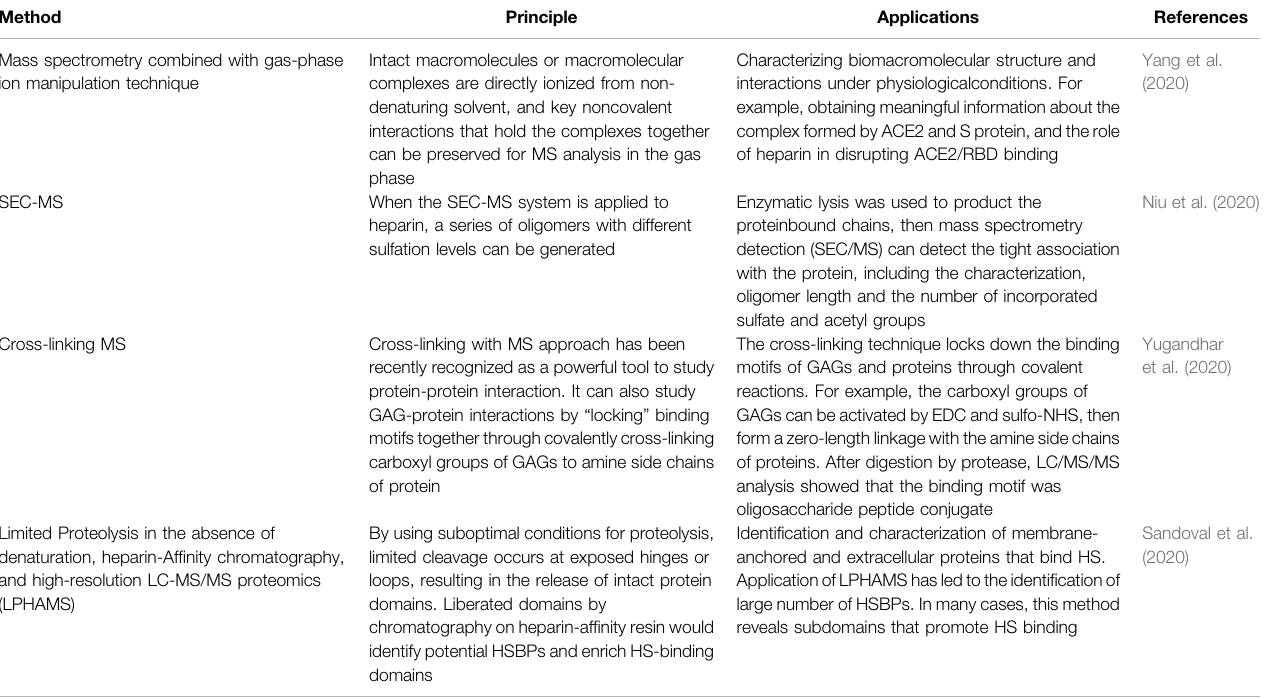
TABLE 2 | The recent advances in mass spectrometry based analytical tools is